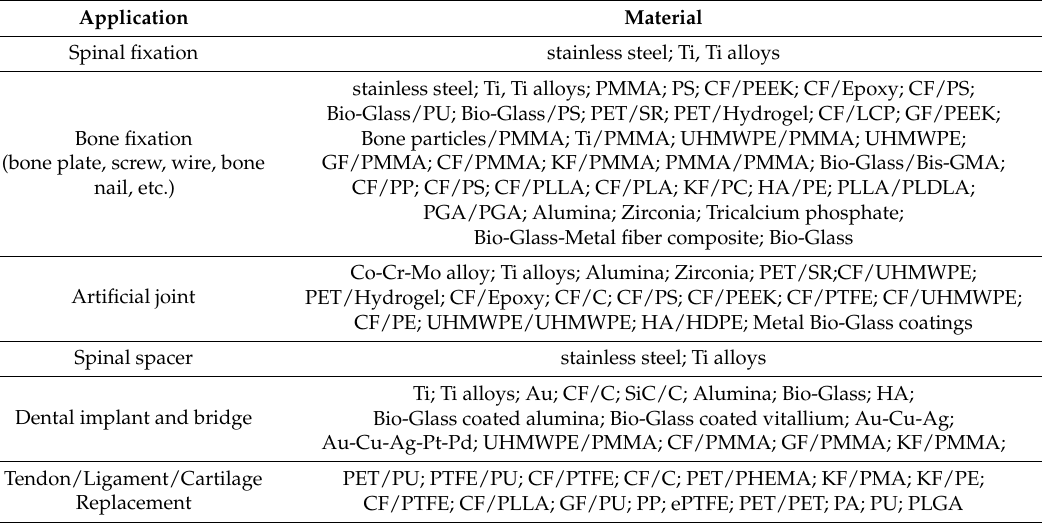
Table 1. Biomedical applications of biocompatible materials